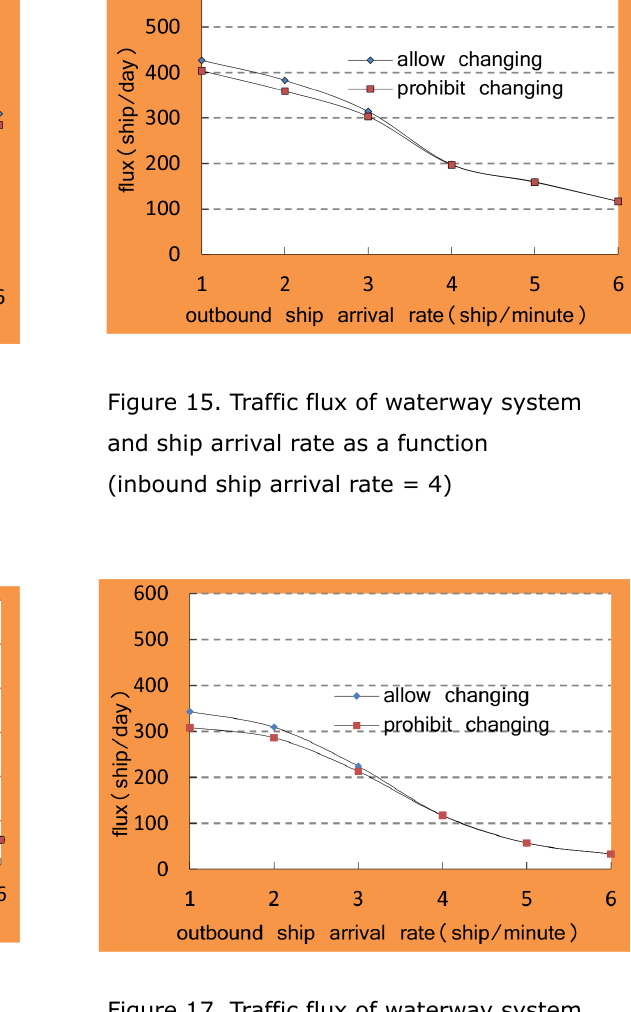
Figure 16. Traffic flux of waterway system and ship arrival rate as a function (inbound ship arrival rate = 5)